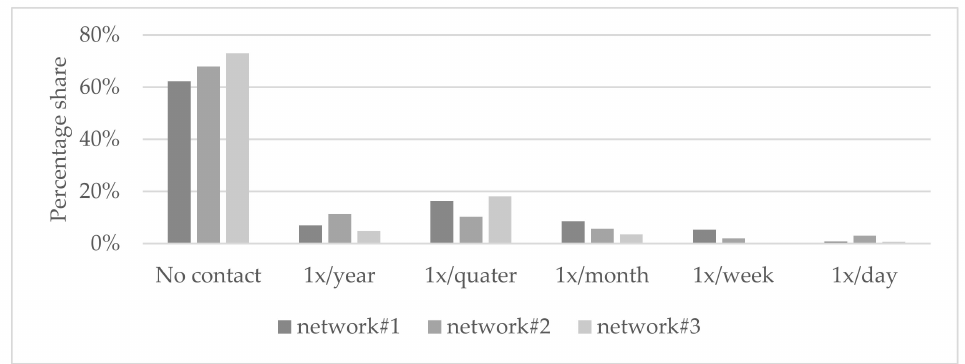
Figure 3. Distribution of contact frequency for all networks.